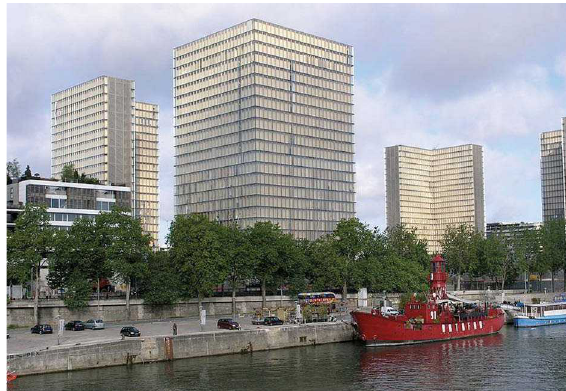
Fig 5. Peckham Library in London (1999)